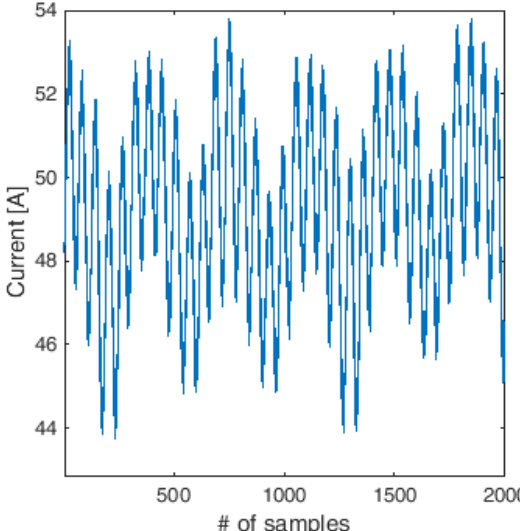
Figure 14. Current profile of the supplied current from the battery pack during the dumpster lift operation. lift operation.